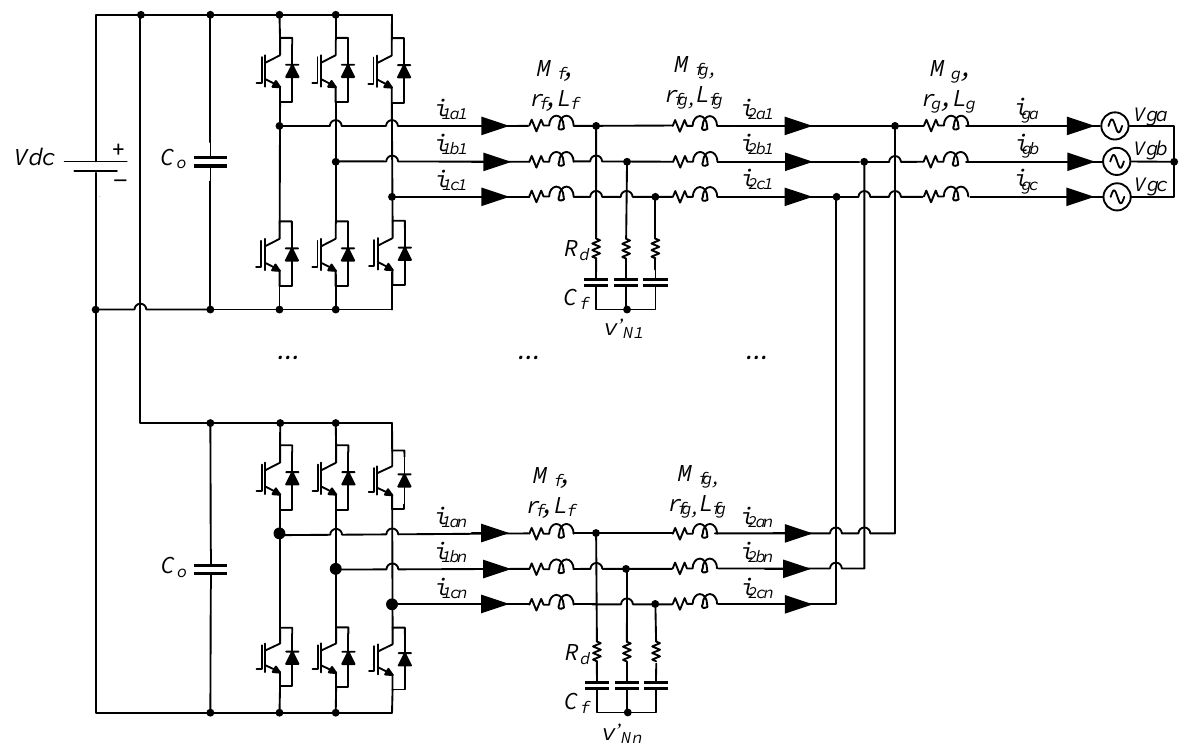
Figure 1. Circuit of the parallel inverters.